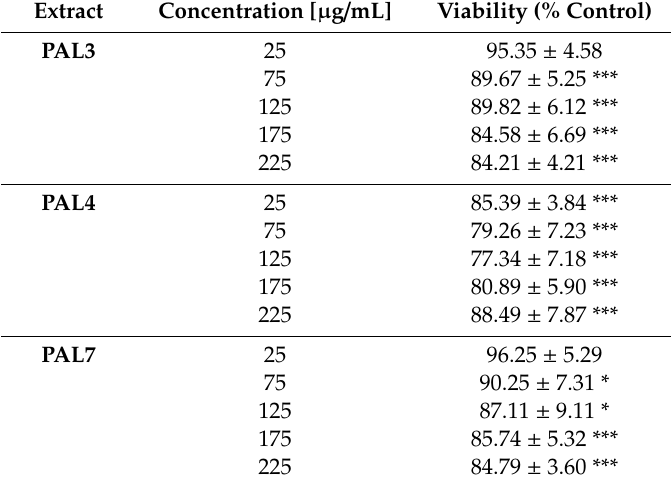
Table 3. The e ff ect of the PAL3, PAL4, and PAL7 on the cell viability of the CCC 841 CoTr line studied using a neutral red (NR) uptake assay. The extracts worked in a dose-dependent manner. The values are compared to the control, regarded as 100%; * p < 0.01, ** p < 0.005, *** p < 0.001, one-way ANOVA, Dunnett’s